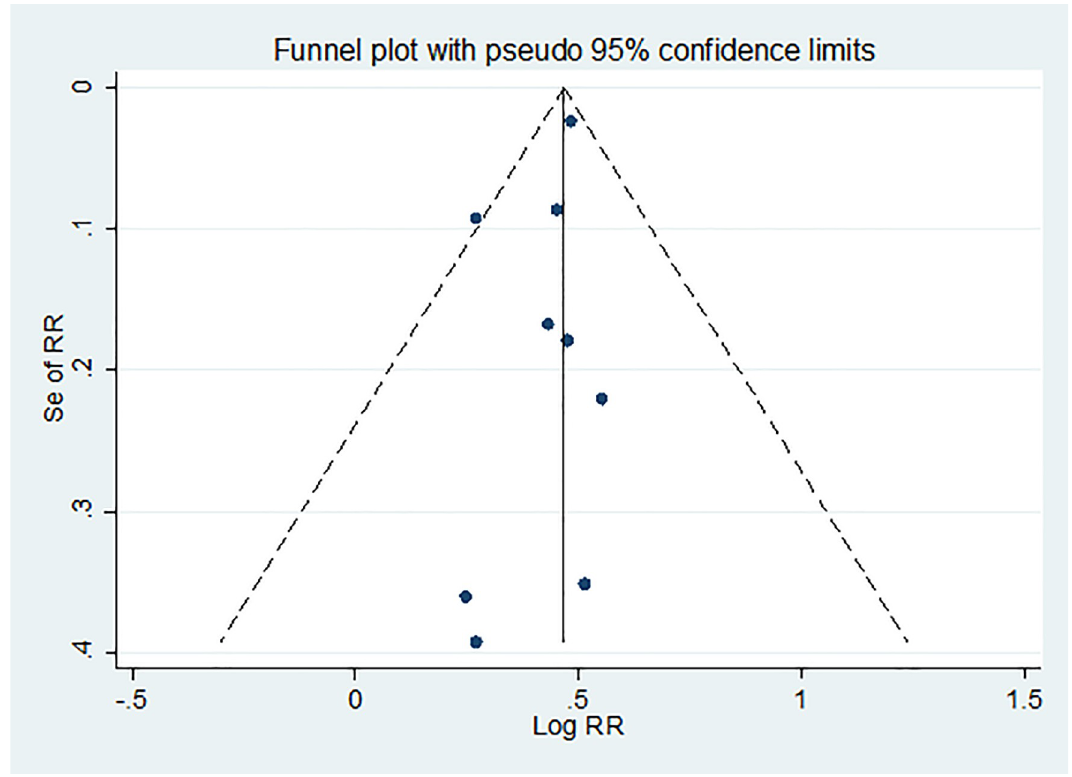
Fig 4. Funnel plot analysis of publication